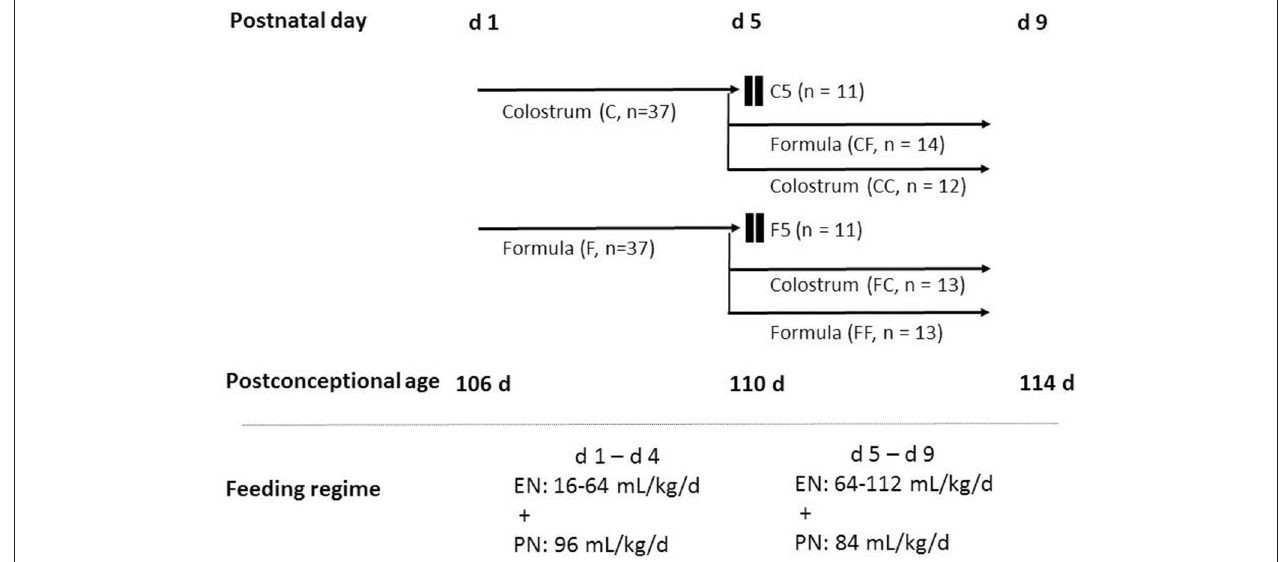
FIGURE 1 | Schematic overview of the animal experimental design. Seventy-four preterm pigs from four sows were delivered at 106 days gestation. The pigs were stratified according to birth weight and gender and allocated randomly into two groups: one group receiving colostrum (C, n = 37) and the other group receiving formula (F, n = 37) for 4 days until day 5 of the experiment. On day 4, pigs in each group were further stratified into three groups to be euthanized on day 5, fed the same feeding for another 4 days, and fed the other diet for another 4 days resulting in six groups: colostrum feeding until day 5 (C5, n = 11), formula feeding until day 5 (F5, n = 11), colostrum feeding for 4 days followed by formula until day 9 (CF, n = 14), colostrum feeding until day 9 (CC, n = 12), formula feeding for 4 days followed by colostrum until day 9 (FC, n = 13), and formula feeding until day 9 (FF, n = 13). Pigs received gradually increasing volumes of enteral nutrition 16–64ml kg − 1 day − 1 on days 1–4 and 64–112ml kg − 1 day − 1 on days 5–8. Parenteral nutrition was given at decreasing rates of 96–84ml kg − 1 day − 1 . C, colostrum; EN, enteral nutrition; F, formula; PN, parenteral